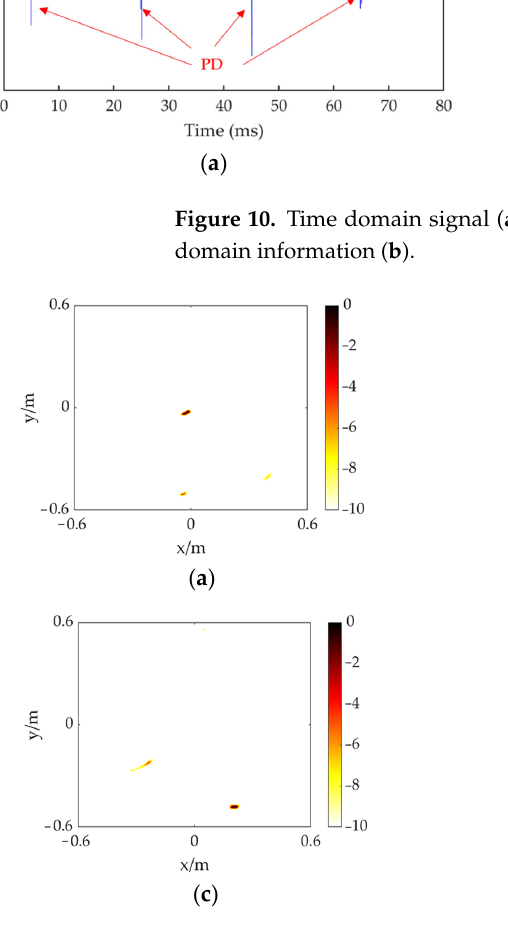
Table 2. The localization results and errors.